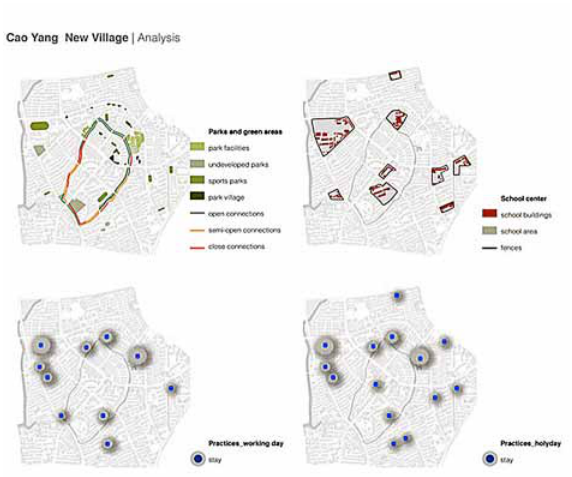
fig. 4. analysis of Cao Yang: park and green areas, school center, practices (Elaborated by the